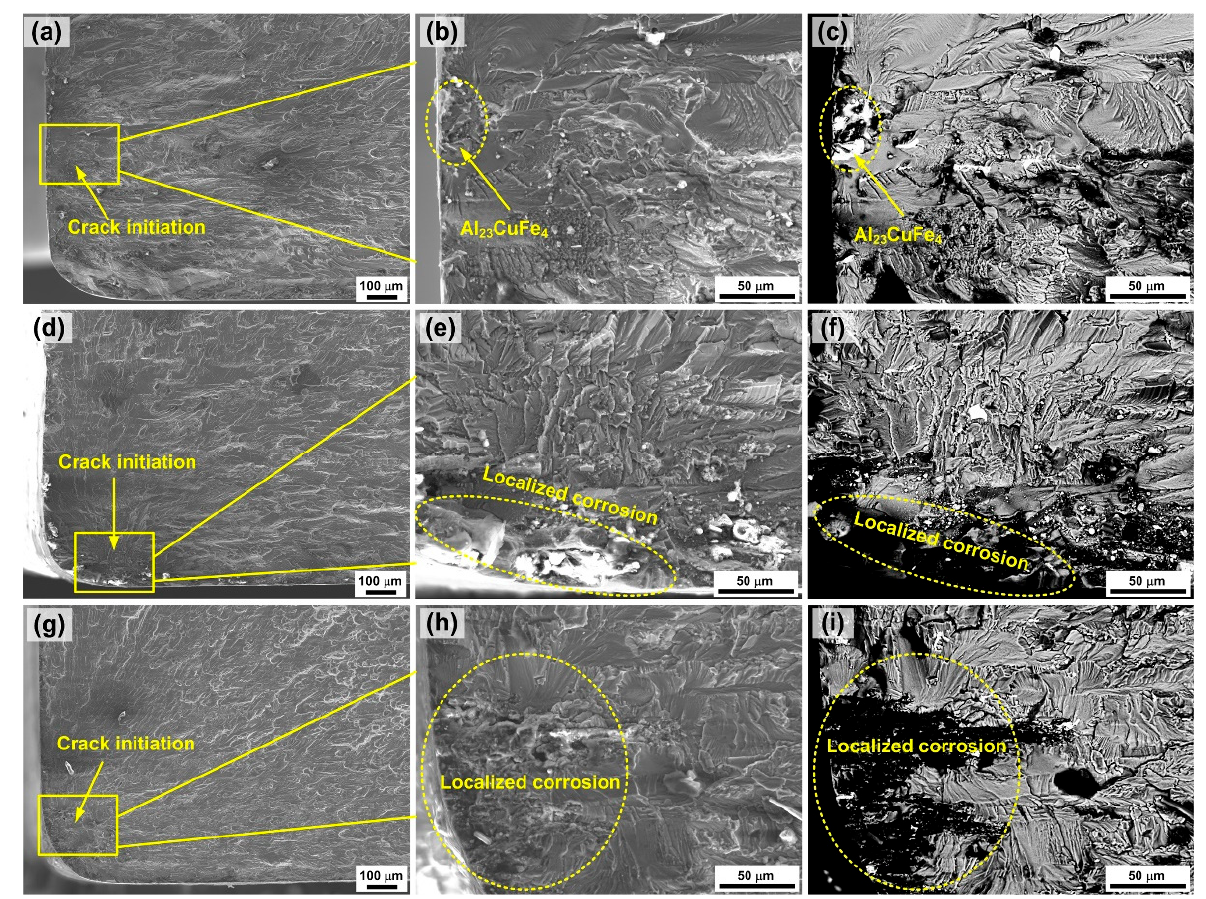
Figure 8. SEM secondary electron and backscattered electron images of fatigue fracture morpholo- gies of 7075-T73 aluminum alloy specimens exposed outdoor for different days: ( a – c ) 0 days; ( d – f ) 15 days; ( g – i ) 180